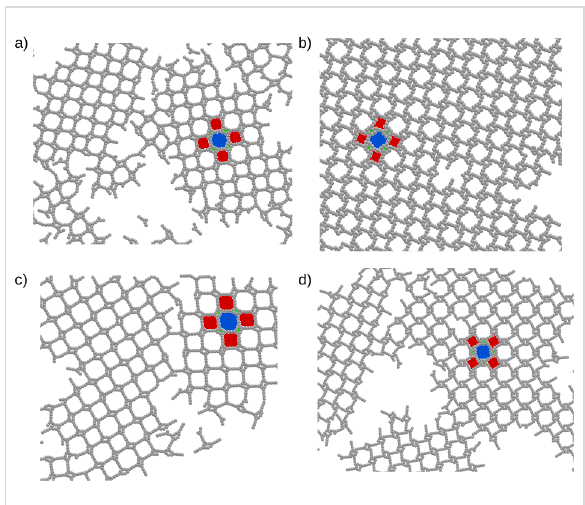
Figure 4: Parts of the configurations of a) NL221 , b) WL221 c) NL321 , and d) WL321 , all with ρ * = 0.2 at T * = 0.56.